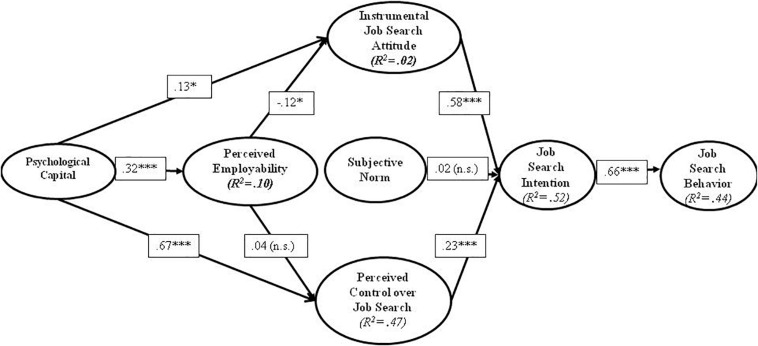
Structural model. Standardized results.